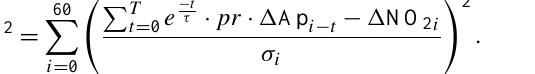
Fig. 4. Correlation coefficient r of the SEA with respect to ∆ Ap (epoch type 2) between ∆ Ap and ∆NO 2 with a delay of one day, plotted over geographic latitudes.